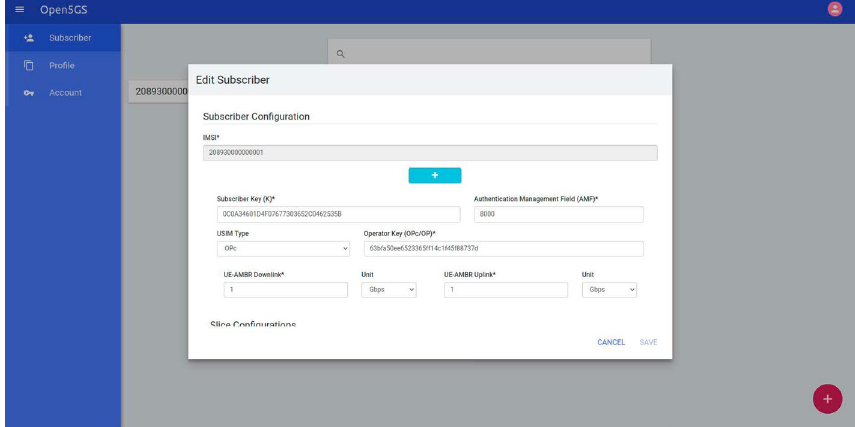
Fig. 5 Open5GS Subscriber Configuration: Configuring the Subscriber(s) in the Open5GS